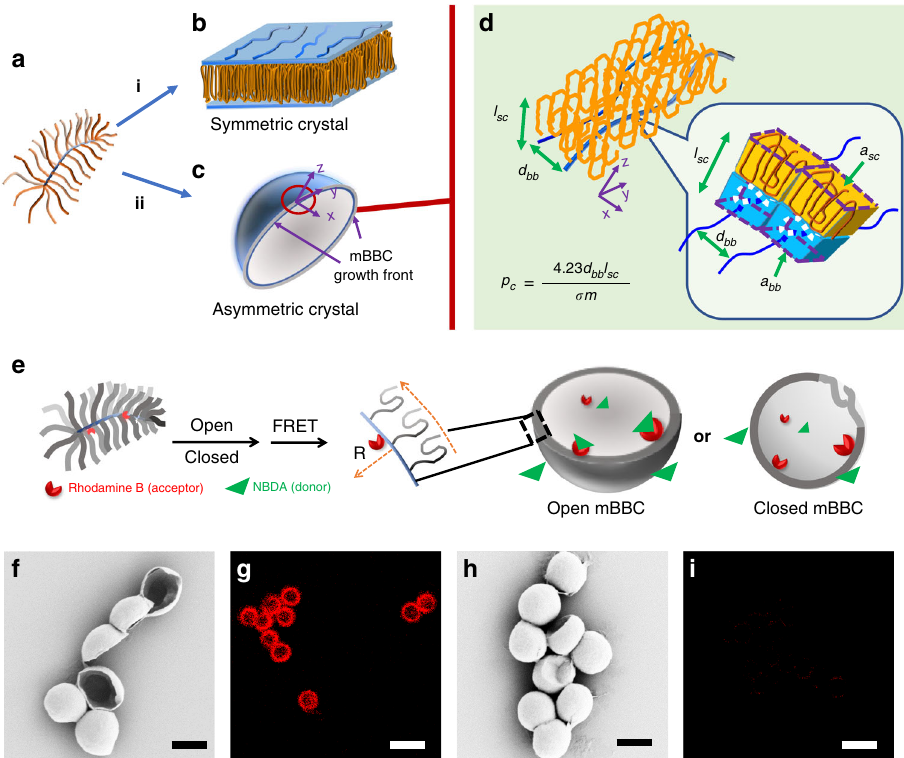
Fig. 2 mBBC formation mechanism. An mBB ( a ) could crystallize following pathway i to form a fl at symmetric crystal ( b ). The blue shaded areas denote mBB backbones/spacers. Pathway ii leads to an asymmetric crystal ( c , d ), where ( d ) is an enlarged view of c . x and z denote growth direction and the PEO axis, respectively. Two mBB molecules are shown in ( d ). Note that each PEO side chain forms multi-stem layers ( yz plane) orthogonal to the growth direction x to alleviate local packing crowdedness. The local chain crowdedness in high grafting density mBB polymers leads to cross-sectional area mismatch between the mBB backbone and side chain crystals, which induces lamella bending, translational symmetry breaking and the subsequent formation of mBBCs. The inset in ( d ) highlights one side chain per mBB molecule. The side chain crystallizes into a small yellow rectangular frustum with de fi ned chain folding, while the blue rectangular frustum represents the volume of the closely packed amorphous layer. ( e ) Schematic illustration of FRET experimental design. ( f , h ) SEM images and ( g , i ) corrected FRET images of open ( f , g ) and closed ( h , i ) mBBCs of mBB 800 -PEO 114 -75-Rh. Scale bars: 2 μ m in ( f , h ) and 5 μ m in ( g , i